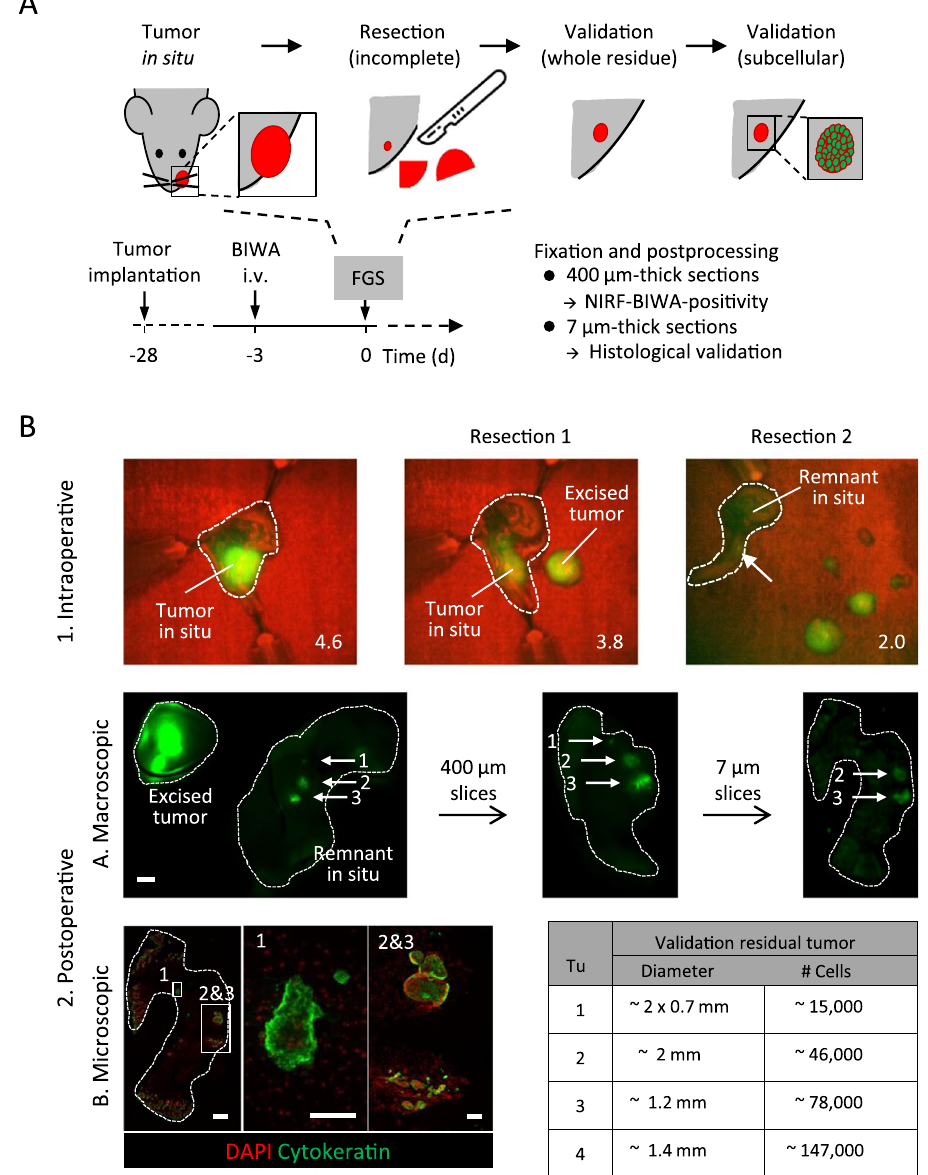
Figure 5. Preclinical FGS using BIWA-IRDye800CW and post-resection validation. ( A ) Experimental procedure of step-wise tumor resection, in situ detection and post-fixation analysis. ( B ) (1) UT-SCC58 tumors 28 days after implantation into mice were monitored by intraoperative fluorescence imaging (QMI Spectrum) followed by step-wise FGS. Dotted lines mark the mouse and tumor tissue and the arrow indicates weak fluorescent signal from tumor remnant in situ . Numbers show tumor-to-background ratios. (2) Post-operative high-sensitivity NIR fluorescence analysis of excised tissues and in situ remnant using the Odyssey CLx flatbed scanner. The scale bar indicates 1 mm. Further processing and re-scanning of the tumor remnant as 400- and then 7- µ m thick sections. Immunofluorescence of a NIRF-positive 7 µ m section of the remnant. Scale bars indicate 500 µ m (overview) and 100 µ m (zoom). The total estimated remnant tumor cells and size are shown for four